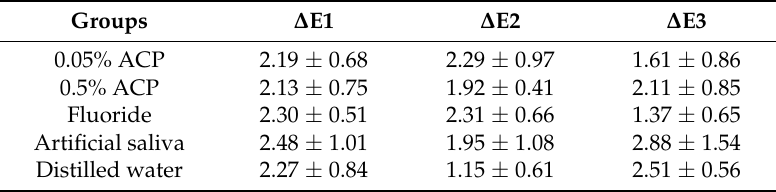
Table 1. ∆ E1, ∆ E2 and ∆ E3 for five